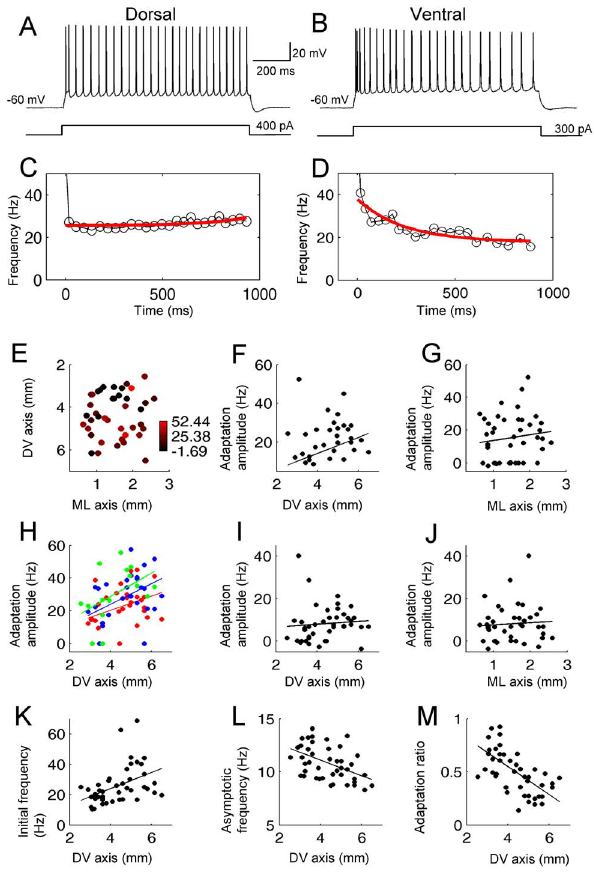
Figure 3. Spike frequency adaptation is greater in ventral cells in carbachol. (A and B) Train of action potentials elicited in a dorsal (A) and a ventral (B) neuron during 1 s pulse injection. (C and D) Instantaneous frequency of neuron in A and B, respectively (black). The red line shows the single exponential fit. (E) Color plot of the adaptation amplitude at different locations in the two-dimensions (DV and ML) of anatomical space. Note many red dots in ventral and many darker dots in dorsal locations indicating greater adaptation in ventral cells. (F and G) Adaptation amplitude plotted along the DV and ML axes, respectively. (H) Adaptation amplitude with 300 (red), 400 (green) and 500 pA (blue) current injection. (I and J) Adaptation amplitude without the first two spikes along the DV and ML axis, respectively. (K) Initial firing frequency plotted against the DV axis. (L) Asymptotic firing frequency plotted against the DV axis. (M) Adaptation ratio calculated from the initial and asymptotic frequency.